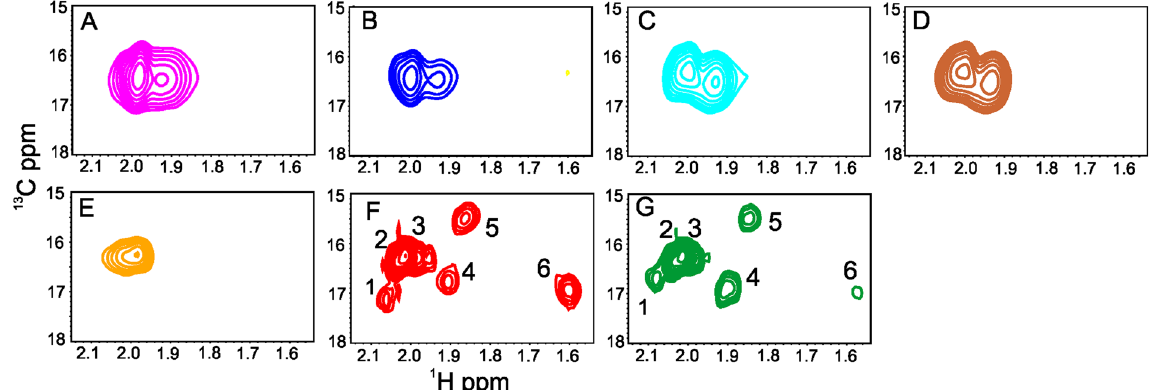
Figure 5. 1 H- 13 C SOFAST-HMQC spectra of 13 CH 3 -methionine labelled malE-en2NTS 1 and en2NTS 1 . ( A ). malE-en2NTS 1 (apo) in DDM ( B ). malE-en2NTS 1 (100 μ M NT 8–13 ) in DDM. ( C ) malE-en2NTS 1 (apo) in Brij58. ( D )